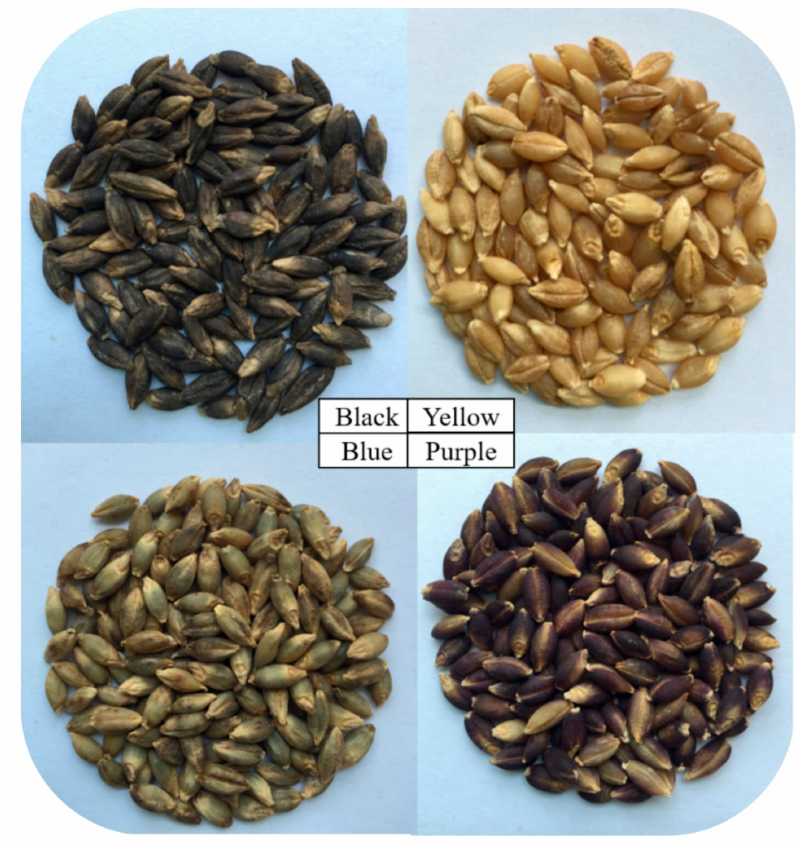
Figure 7. The four highland barley varieties with different